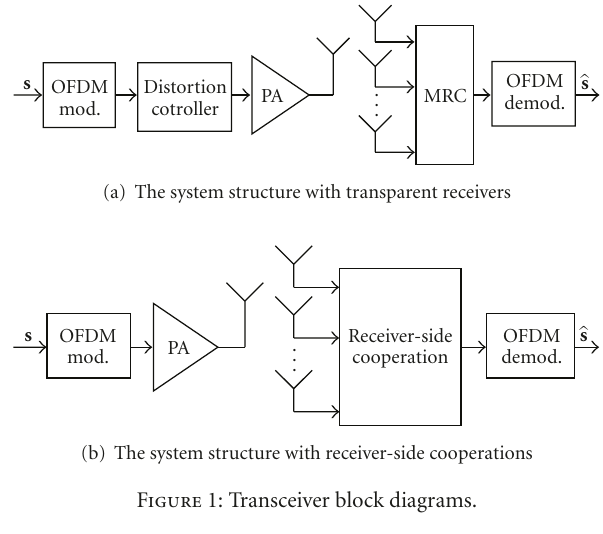
(b) The system structure with receiver-side cooperations Figure 1: Transceiver block